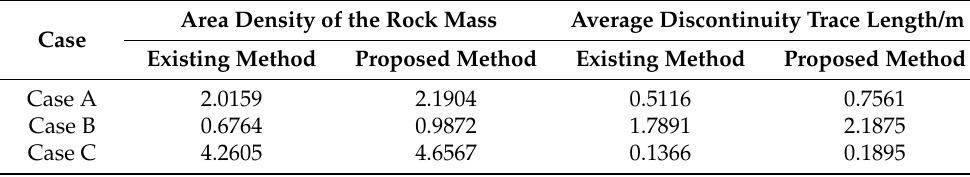
Table 1. Area density and average discontinuity track length of the rock mass.